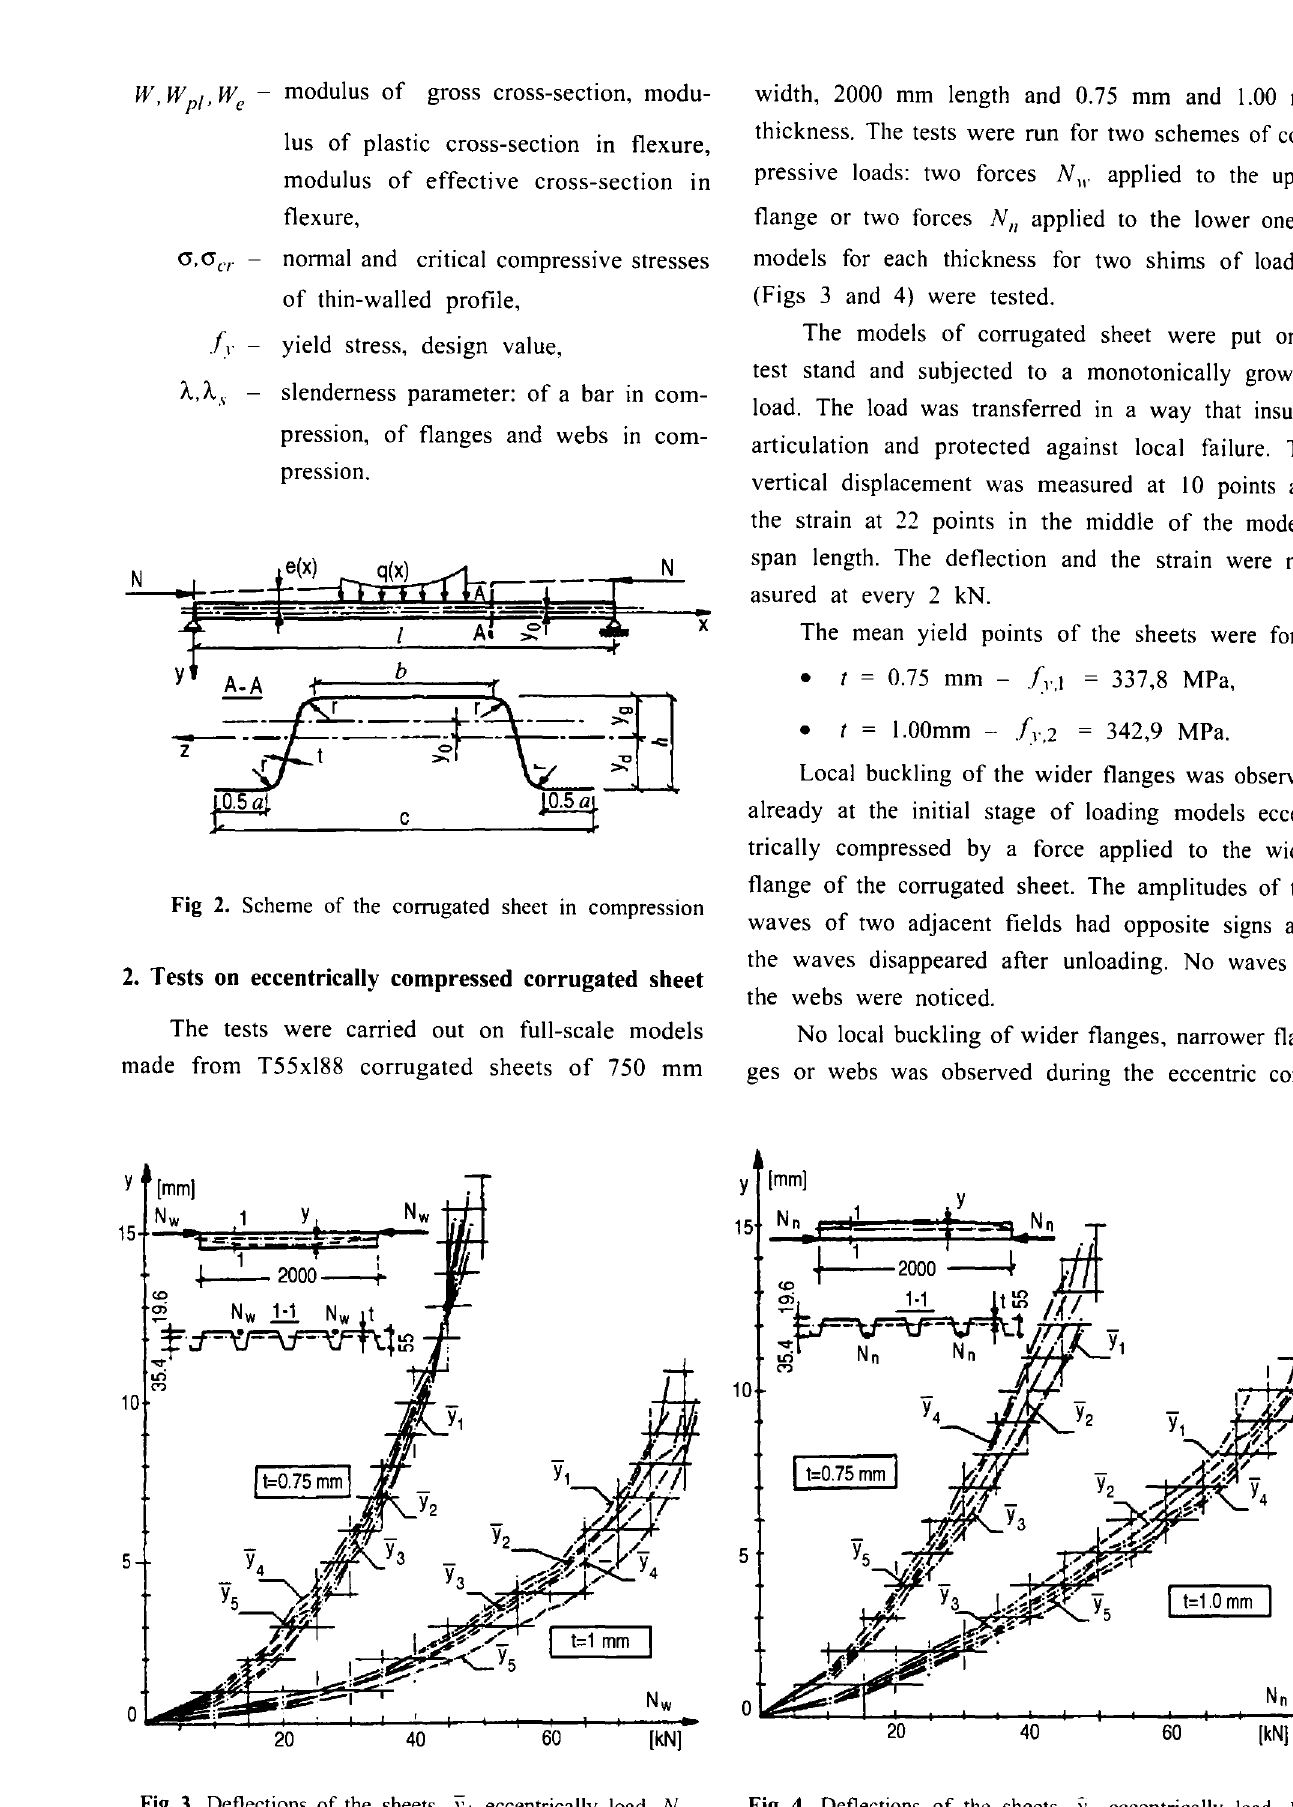
Fig 3. Deflections of the sheets y i eccentrically load N \\. Fig 4. Deflections of the sheets Yi eccentrically load N